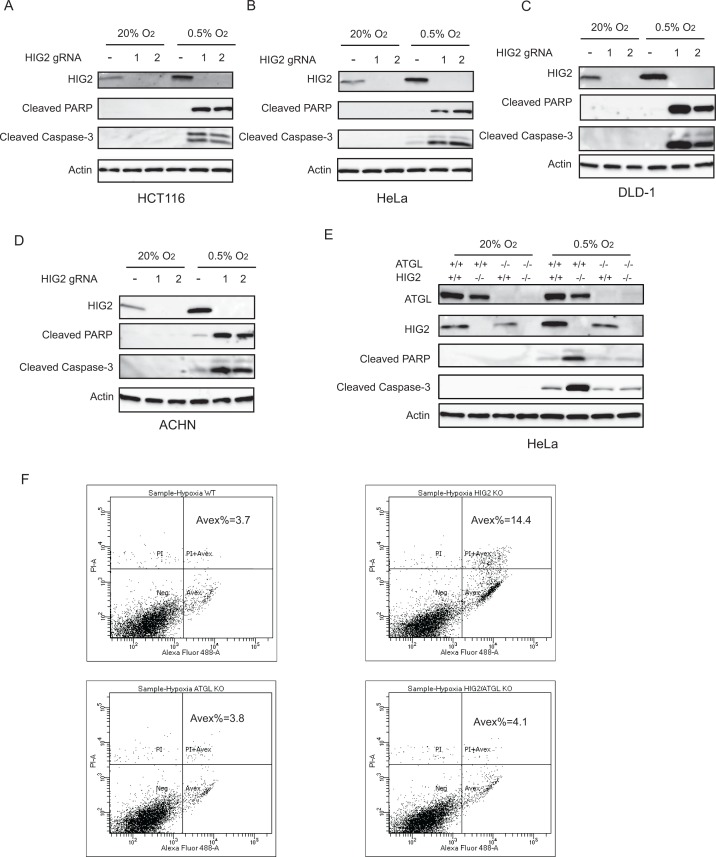
Enhancement of lipolysis induces apoptosis under hypoxia.(A–D) WT or HIG2 deficient clones generated from two independent gRNA were cultured under normoxia or hypoxia for 48 hr (A, B) or 72 hr (C, D). Cell apoptosis was examined by immunoblotting. (E) Immunoblotting of HeLa cell lysates after 48 hr of incubation under normoxia or hypoxia. (F) Representative imaging by Flow Cytometry in Figure 4g (Hypoxia) was shown. Graphs represent mean ± SD, and were compared by two-tailed unpaired Student t-test.